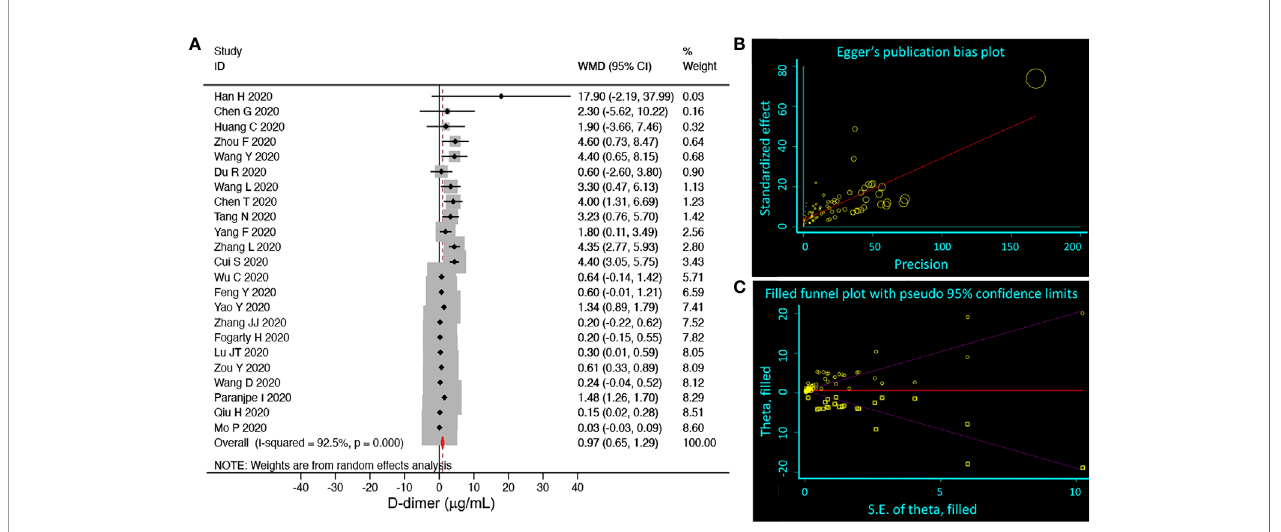
FIGURE 2 | Random-effects meta-analysis of D-dimer level. (A) Forest plot. We selected studies that had subgroups, which could be divided into mild (including normal) and severe groups. We pooled weighted mean differences (WMD, black diamond, and gray square) and 95% CI (horizontal lines through the diamonds) of D-dimer from eligible 23 studies. Studies with only one group or moderate group were excluded. The red diamond represents the overall WMD. (B) Egger ’ s publication bias plot. N=89, P<0.001. (C) Filled funnel plot. P<0.001. Circle, raw data; square, pseudo data needed for symmetric